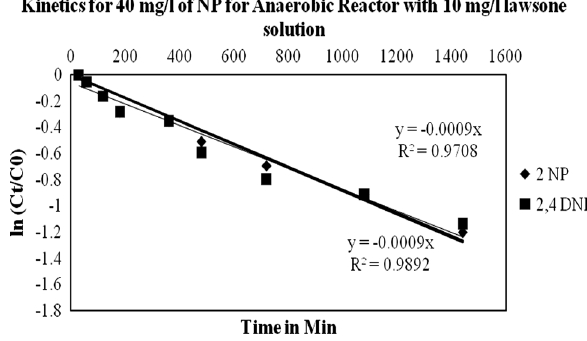
Fig. 14 Kinetics for 40 mg/l nitrophenol loading with 10 mg/l law- sone solution